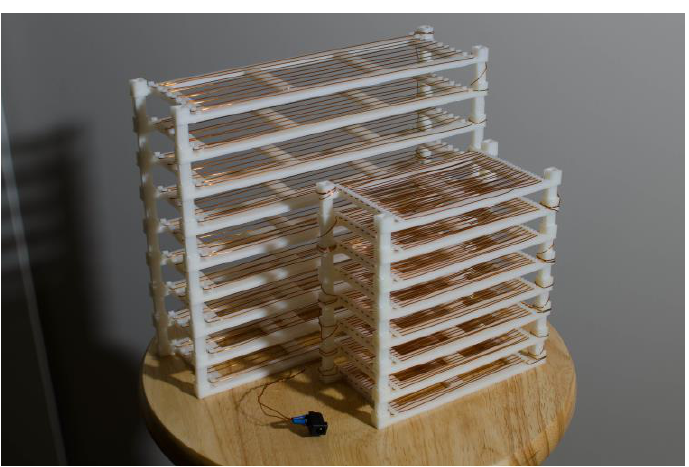
Figure 6. Comparing design options for the open-source slide dryer: 66-slide dryer behind a 30-slide dryer.